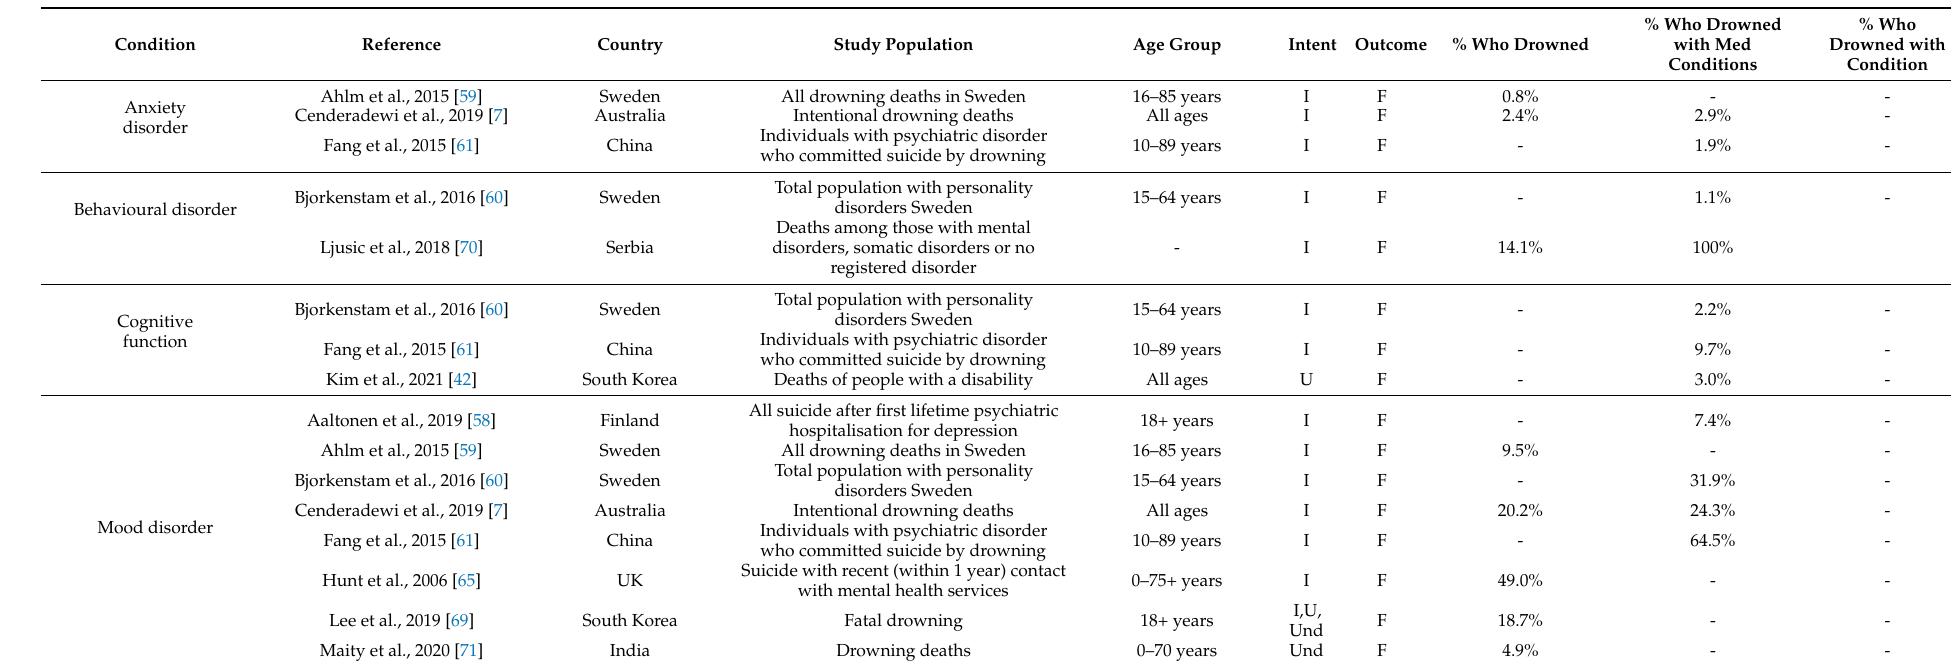
Table 5. Studies reporting conditions within the mental and behavioural conditions